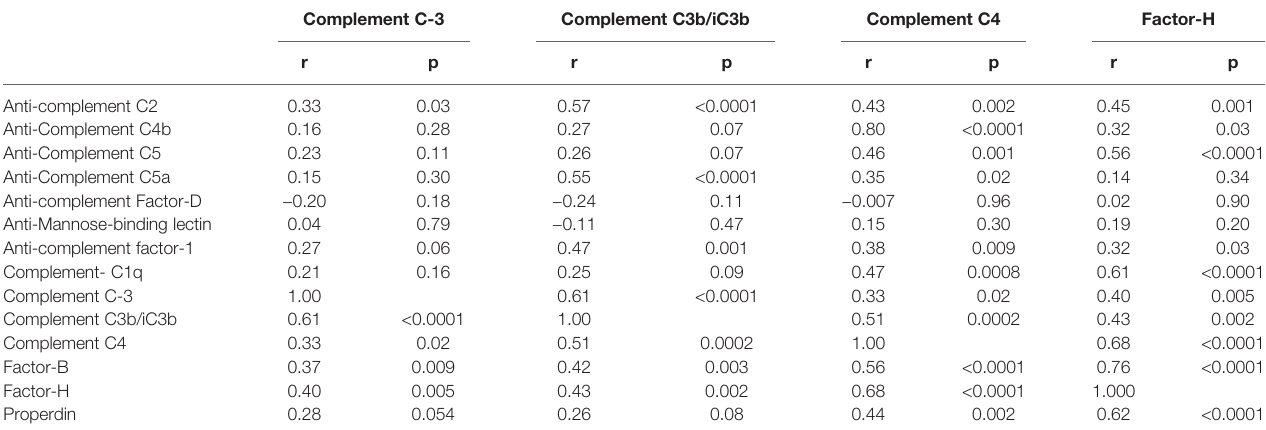
TABLE 4 | Partial correlations of complement C3, complement C3b/iC3b, complement 4, and Factor-H with members of the complement system from the combined cohort (control and GDM) adjusted for age and